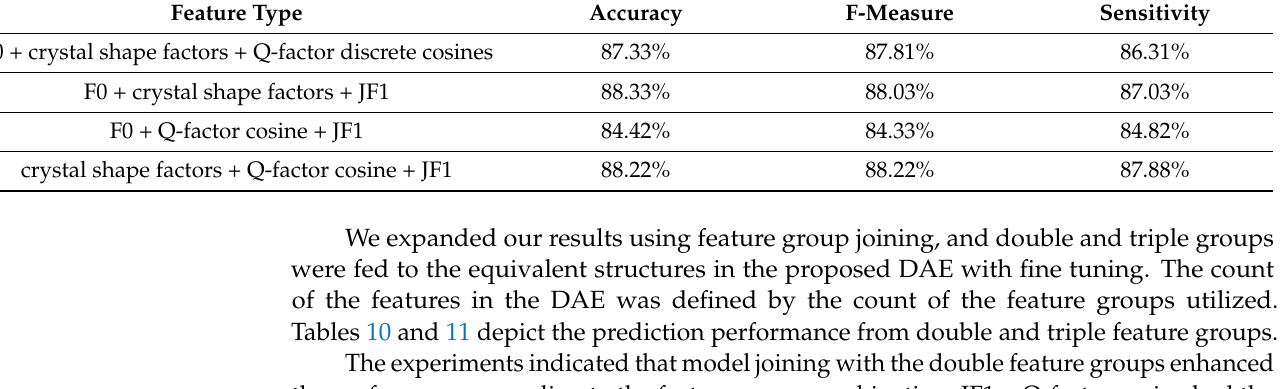
Table 9. Results of Triple Feature Groups for DAE.